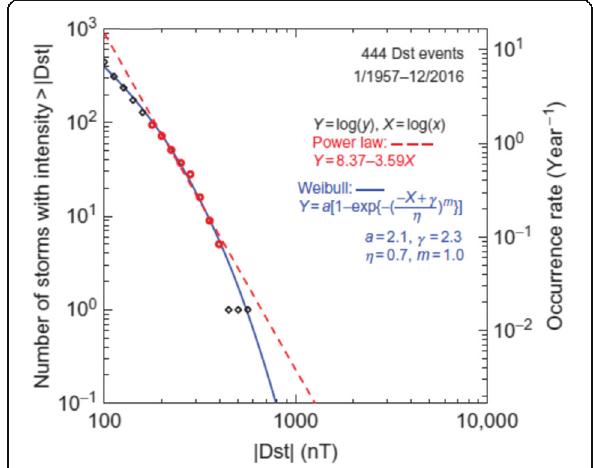
Fig. 8 Cumulative distribution of intense geomagnetic storms (Dst < 100 nT) and their yearly rates since 1957 (taken